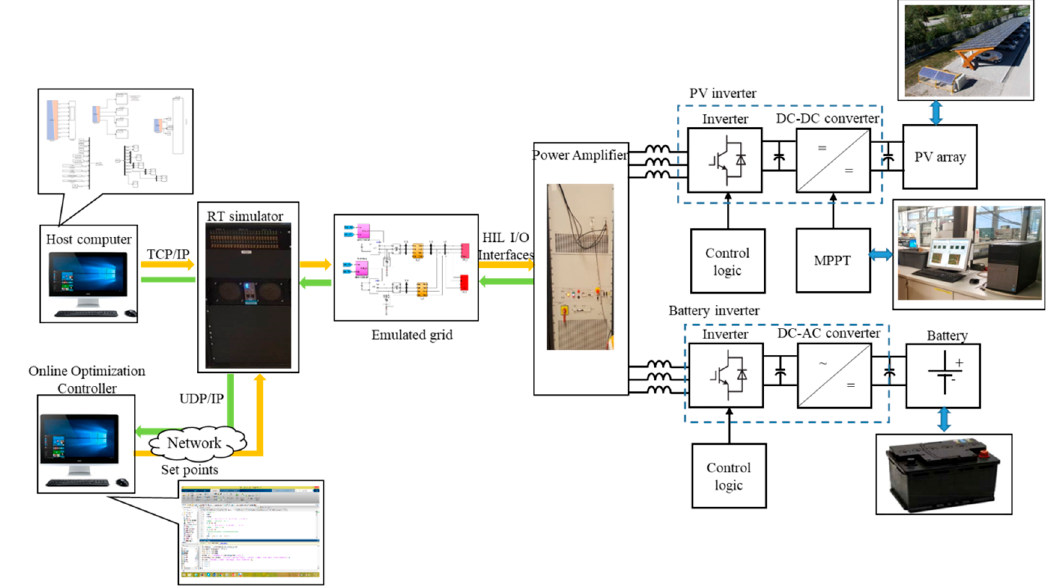
Figure 9. Configuration of the hardware-in-the-loop (HIL) system.